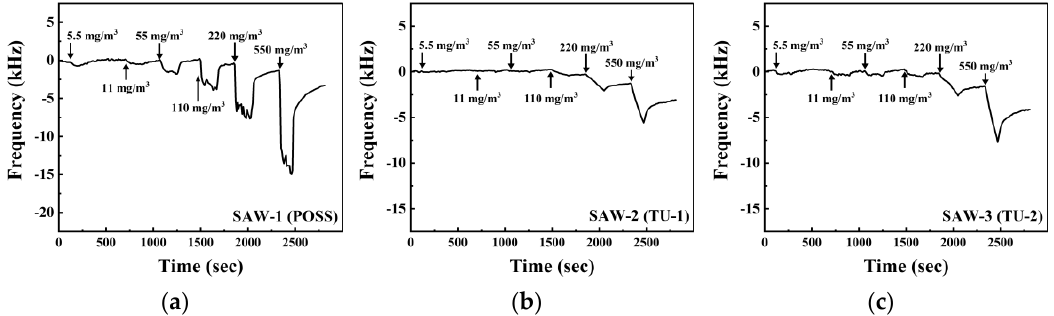
Figure 7. Dynamic response of the SAW sensors coated with different sensing materials: ( a ) POSS; ( b ) TU-1; and ( c ) TU-2 upon exposure to GB at concentrations from 5.5 to 550 mg/m 3 . The inserted numbers are the different concentrations of GB.